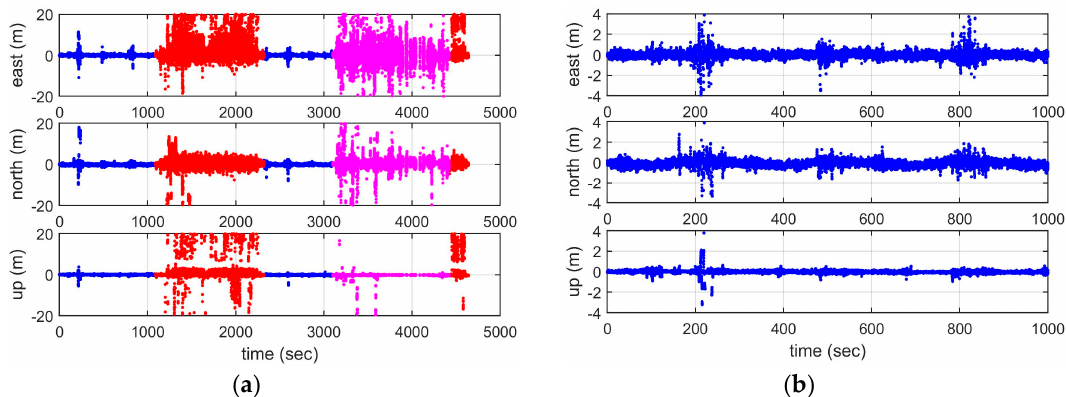
Figure 13. Positioning errors using code pseudorange measurements with robust estimation: ( a ) whole experiment, ( b ) the first 17 minutes.